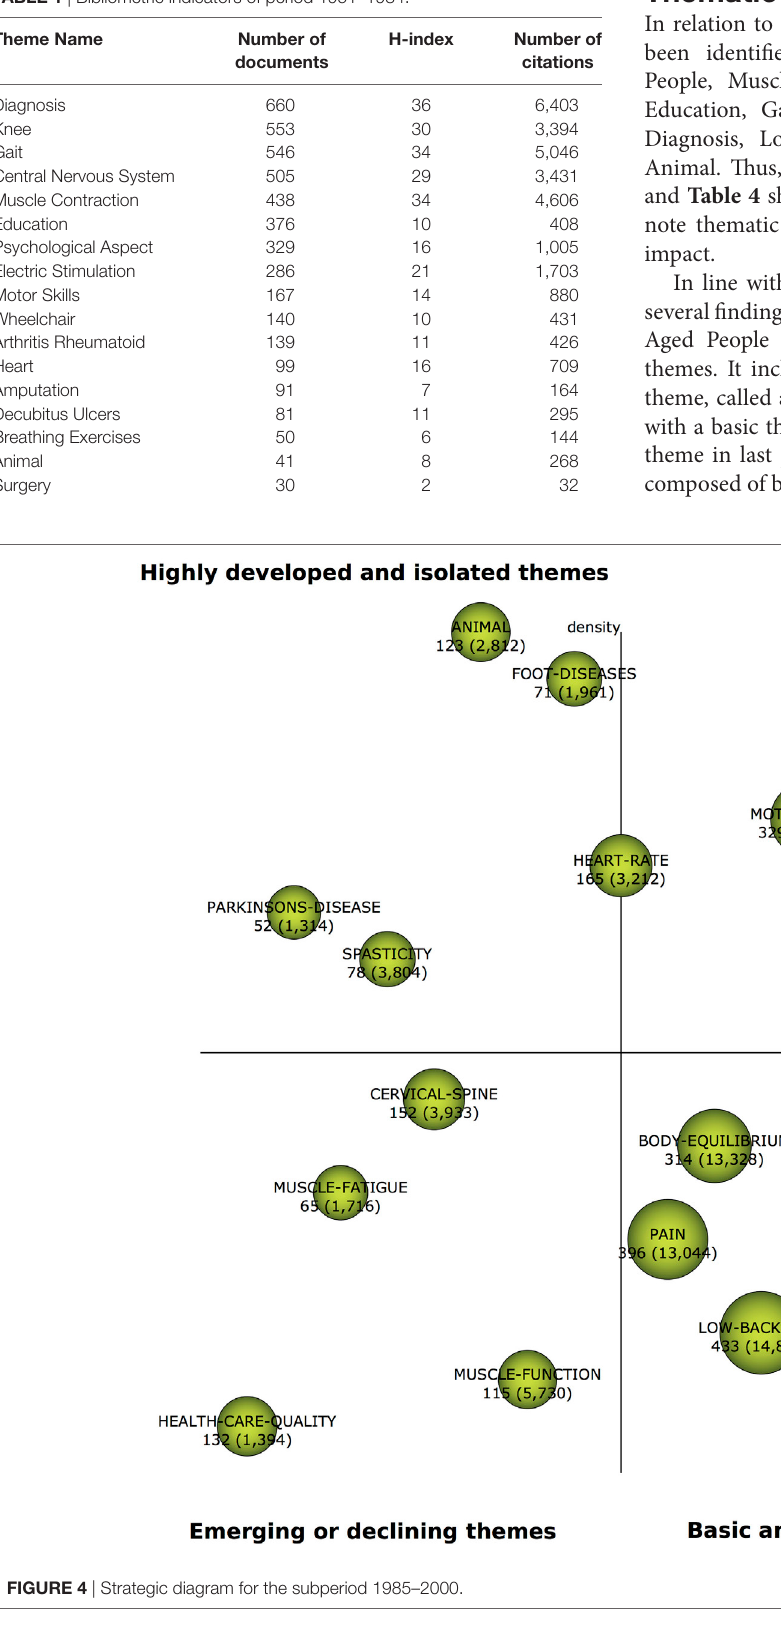
Table 1 | Bibliometric indicators of period